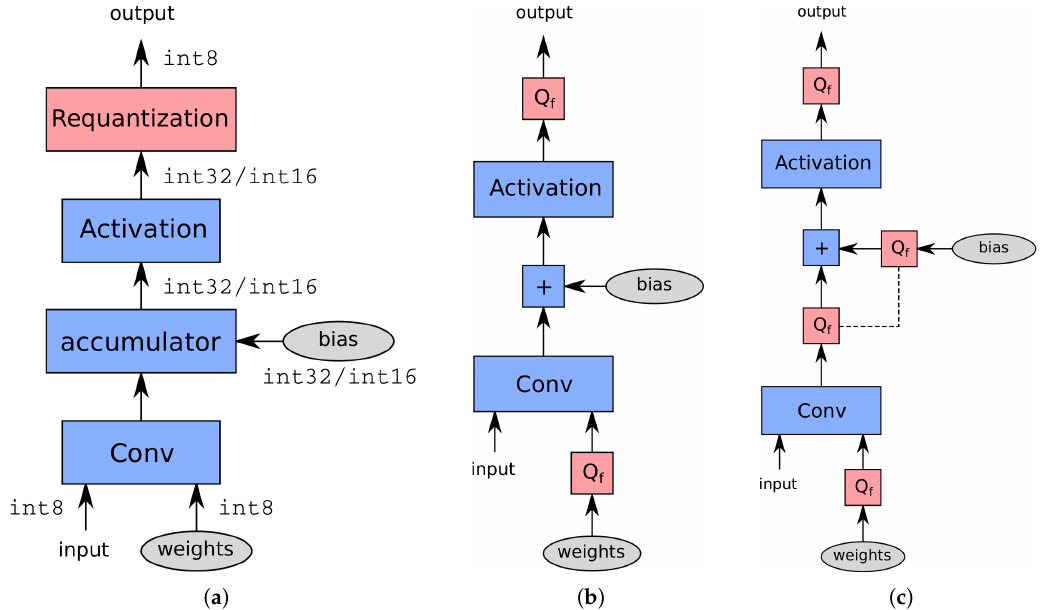
Figure 2. ( a ) Fixed-point compute engine of a convolutional layer; ( b ) simulated fixed-point compute engine with 32 bit accumulator and bias; ( c ) simulated compute engine with 16 bit (or less) accumulator and bias. The dashed line indicates that these fake quantization nodes share the same scale